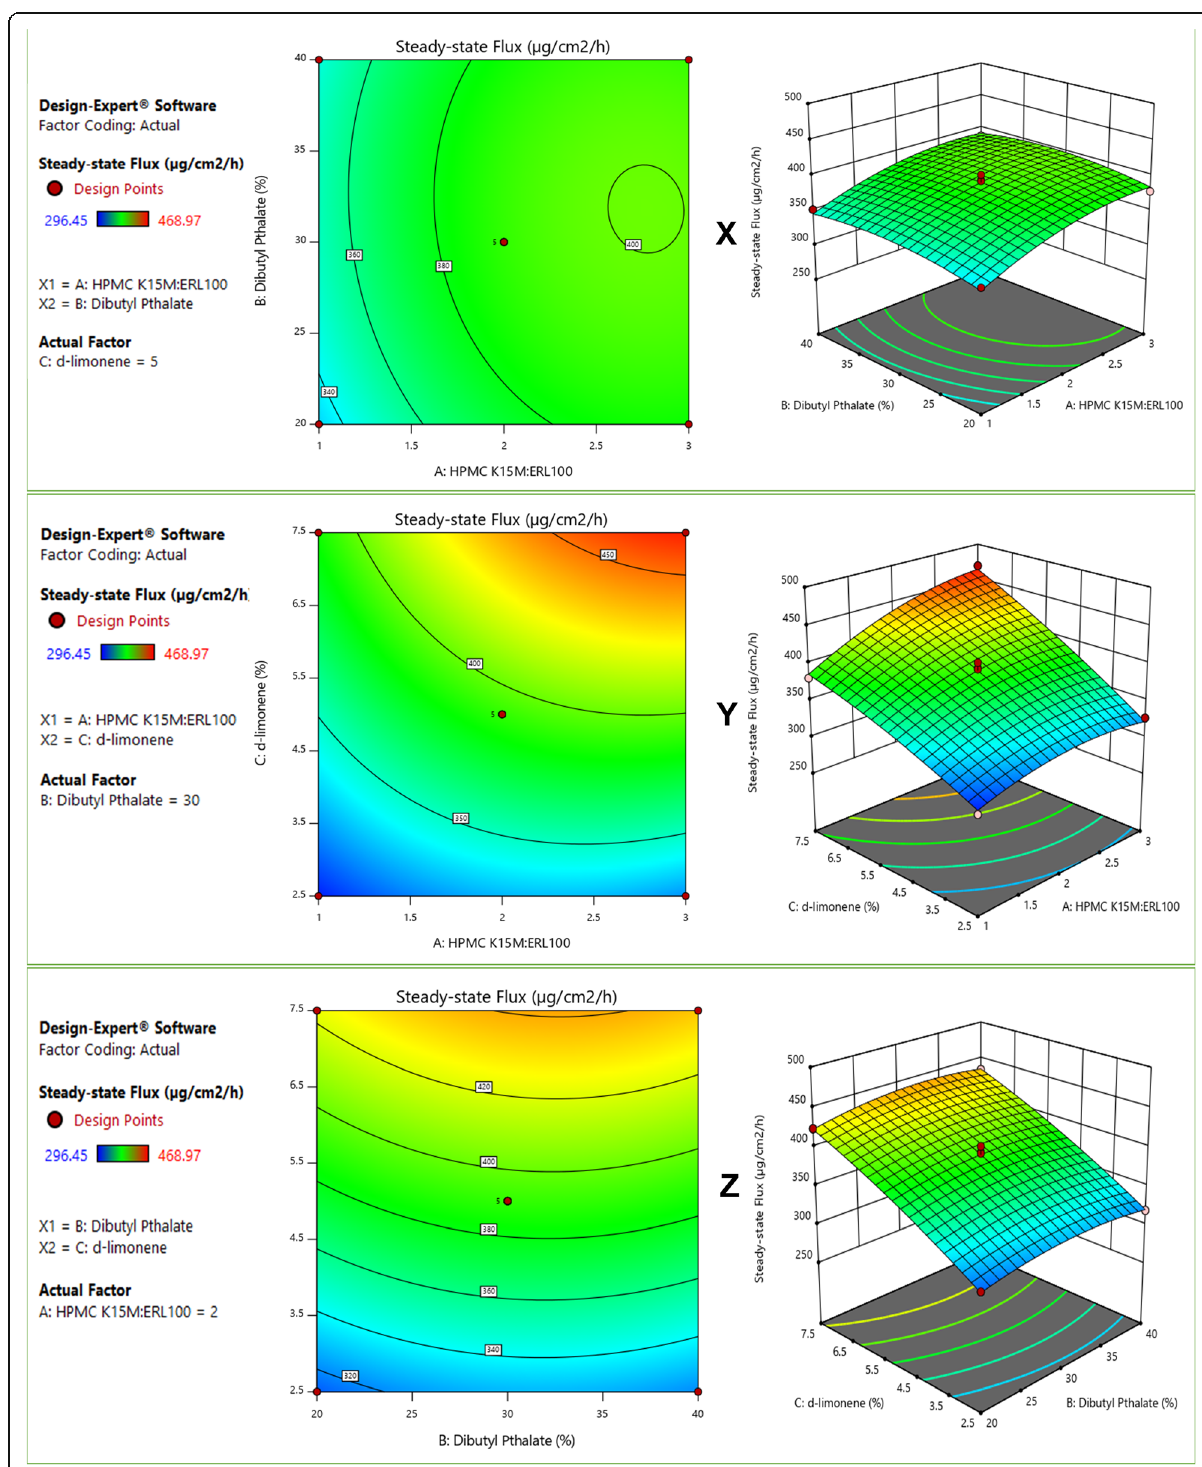
Fig. 4 Response surface plot showing effect of X polymer (HPMC K15M:ERL100) ratio ( a ) and di-butyl phthalate (% w/w) ( b ); Y polymer (HPMC K15M:ERL100) ratio ( a ) and concentration of d-limonene (% w/w) ( c ); Z di-butyl phthalate (% w/w) ( b ) and concentration of d-limonene (% w/w) ( c ) on response R 2 (steady-state